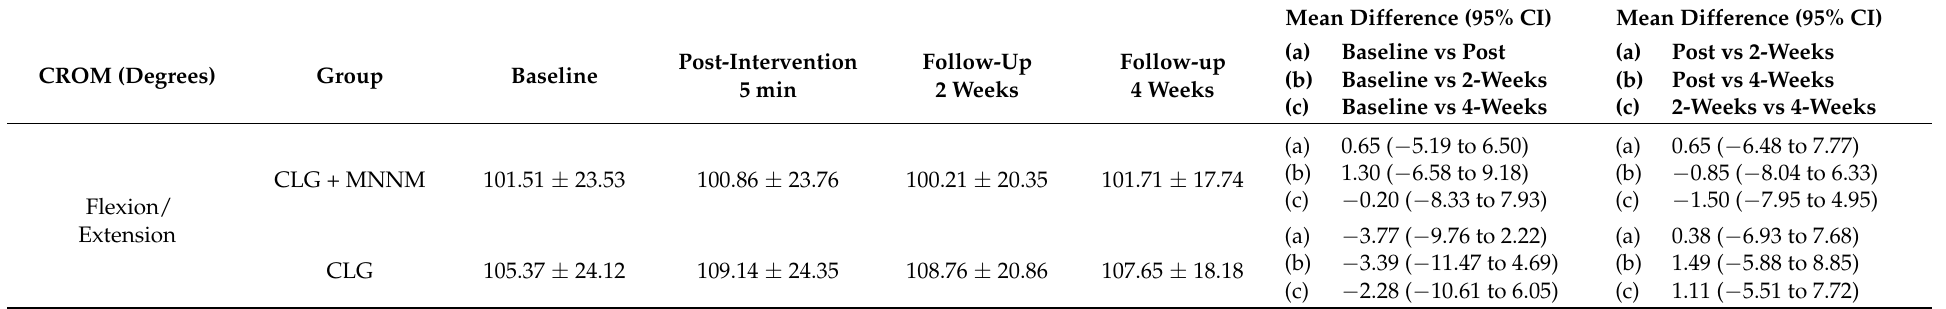
Table 4. Multiple comparisons for active cervical range of motion. Values are the mean ± standard deviation unless otherwise